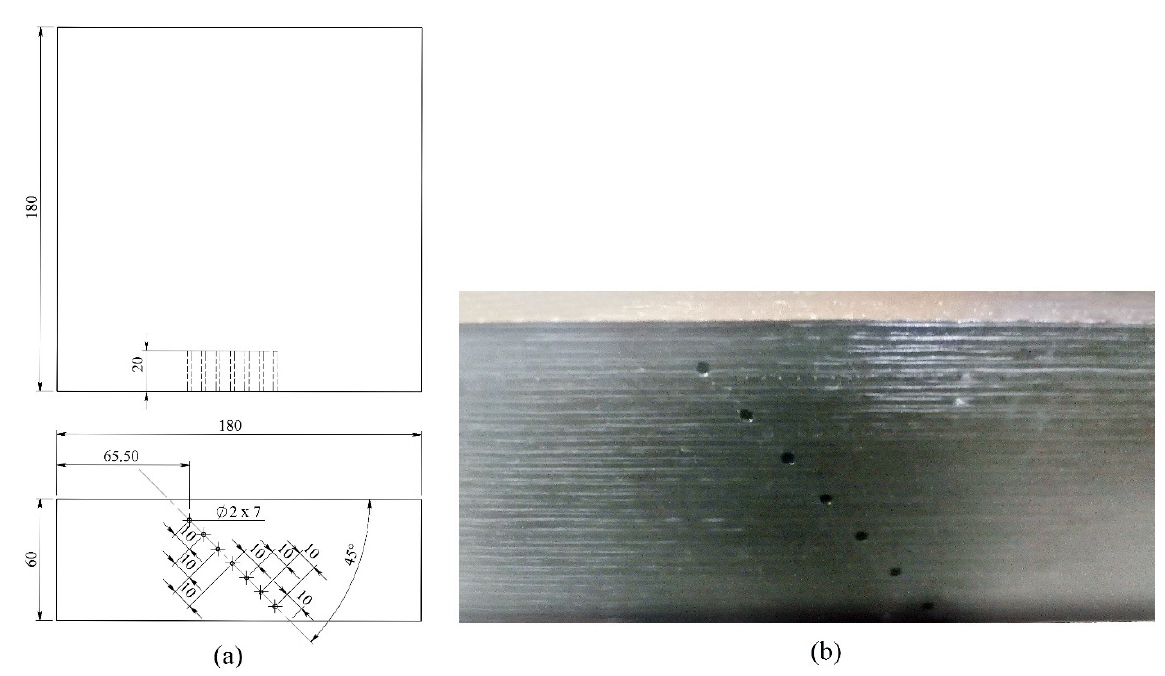
Figure 3. ( a ) Sketch and ( b ) picture of the (60 mm thick carbon fiber-reinforced polymers (CFRP)) sample under test, indicating the side drilled holes located at different depths from the surface of inspection (all the dimensions are in mm).